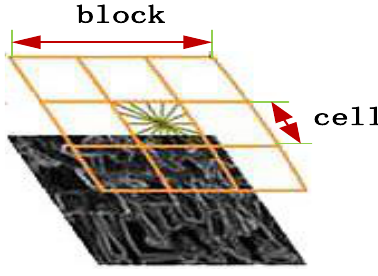
Figure 4. Block-composition diagram.